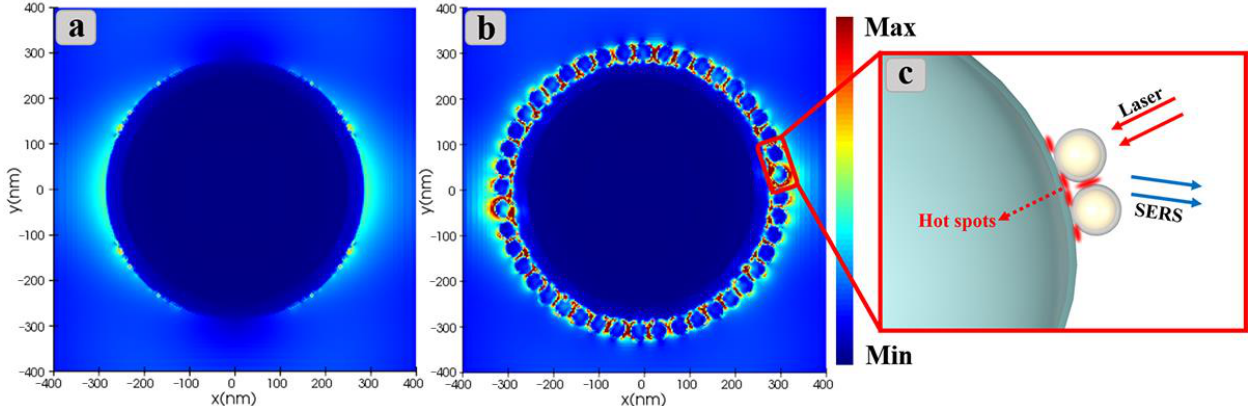
Figure 5. Electric field distribution of FA@Ag ( a ) and CSSN NCs ( b ) obtained by FDTD theoretical algorithm and the diagrammatic sketch of hot spots on CSSN NCs ( c ).